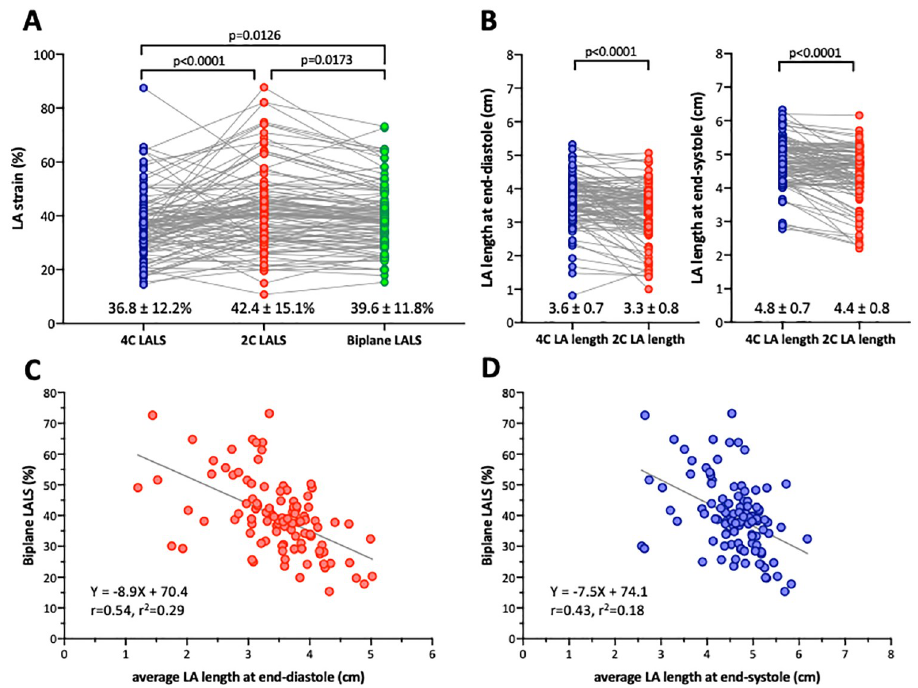
Fig 4. Comparisons of left atrial strain and length using 2DE analysis. A: LA longitudinal strain in apical four- chamber view (4C LALS), apical two-chamber view (2C LALS), and their average (biplane LALS). B: LA length comparing apical four-chamber and apical two-chamber at end-diastole (left panel) and at end-systole (right panel). C: A linear correlation between average left atrial length at end-diastole and biplane left atrial longitudinal strain. D: A linear correlation between average left atrial length at end-systole and biplane left atrial longitudinal strain.